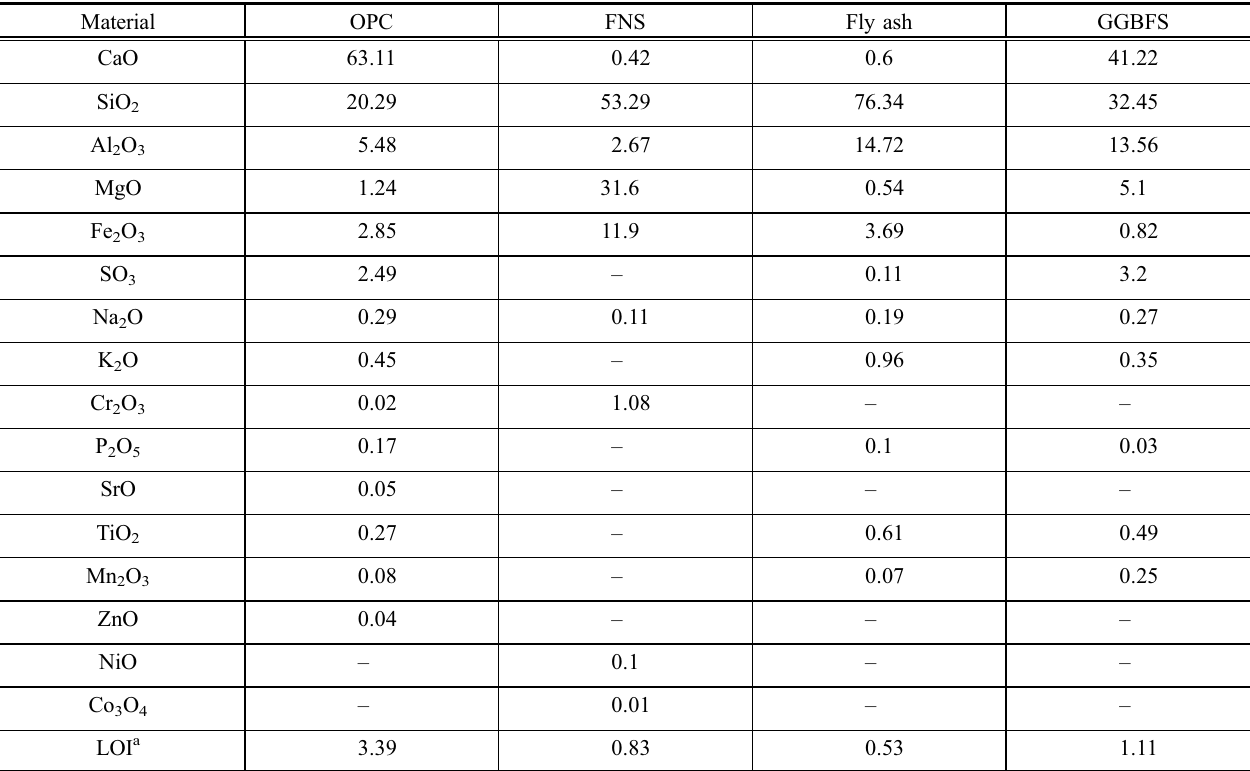
Table 1 Chemical compositions and loss on ignition (LOI) of OPC, FNS, fly ash and GGBFS (mass%).